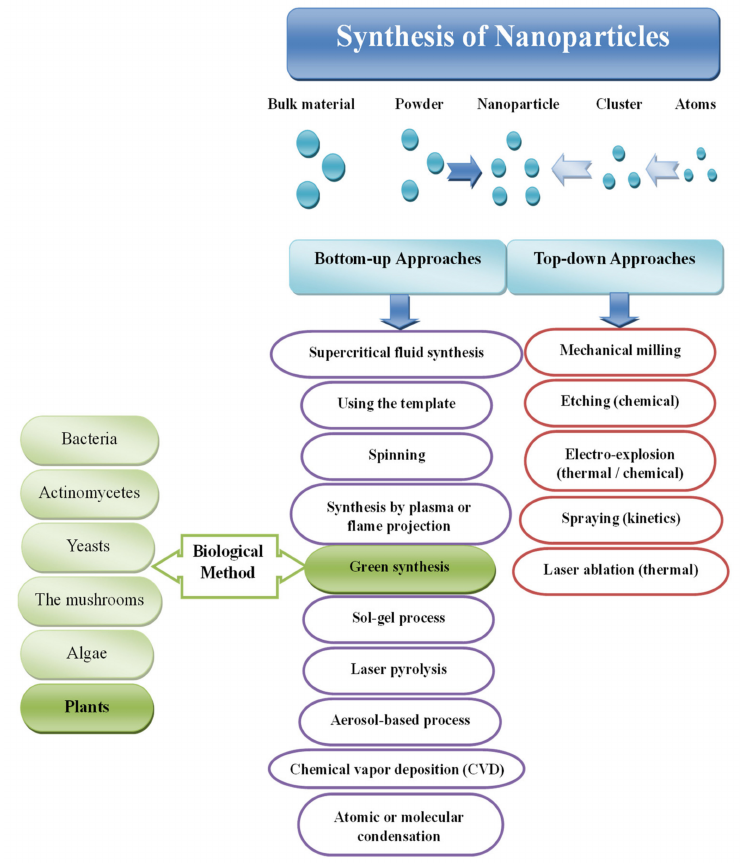
Figure 1. Techniques for synthesis metal NPs, modified with permission from Ref. [17], MDPI,